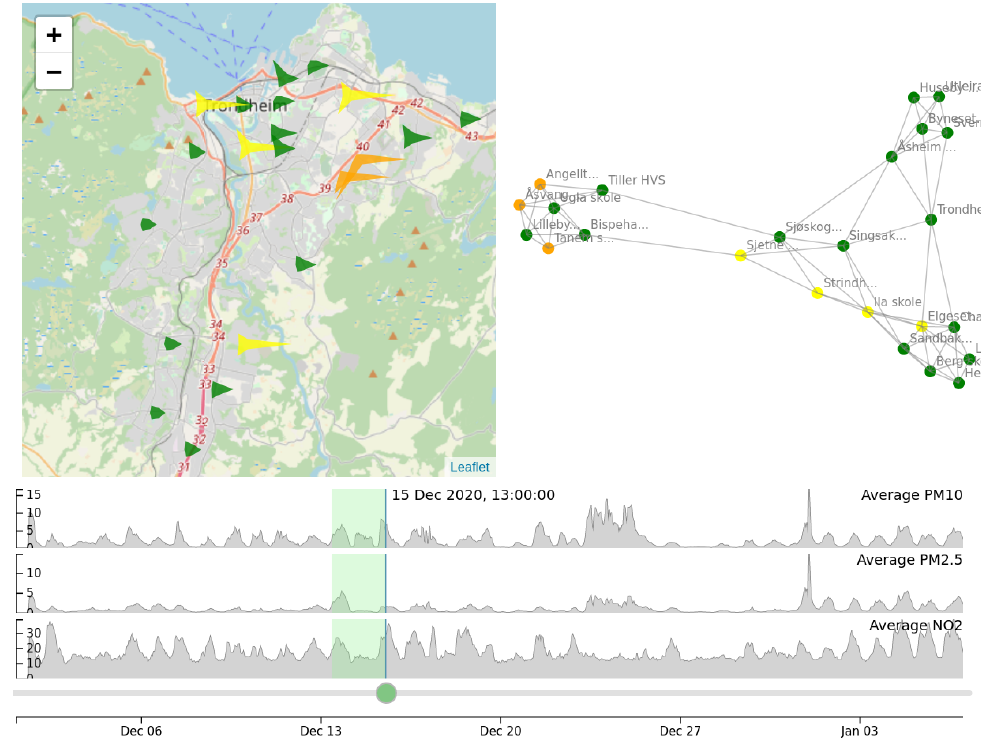
Figure 8. Visualizations for the low-cost sensor data. Left: map view; a star-like glyph is used to display the measurements of each sensor. Right: graph view; each sensor corresponds to a node, with nearby nodes denoting similar measurements. Bottom: timeline view; the progress of the pollutants in time.